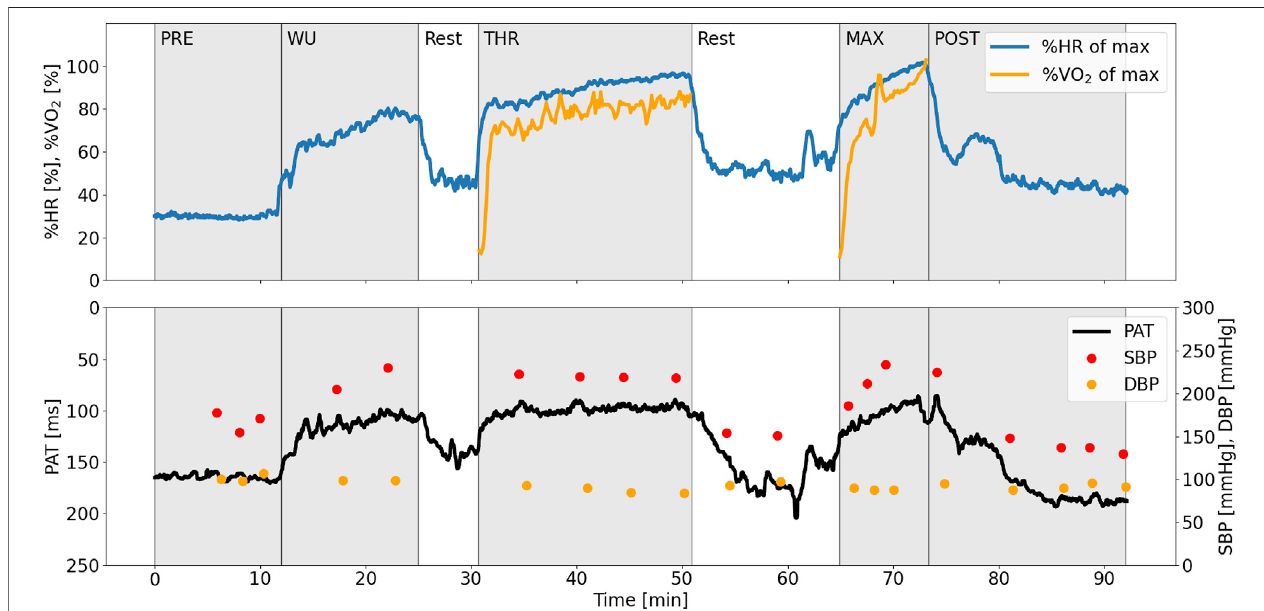
FIGURE 3 | Physiological measurements during the experimental protocol, exempli fi ed with data from one typical subject. PAT is inverted on the y -axis to better visualize the co-variation with SBP. PAT, pulse arrival time (ms); SBP, systolic blood pressure (mmHg); DBP, diastolic blood pressure (mmHg); HR, heart rate (beats per